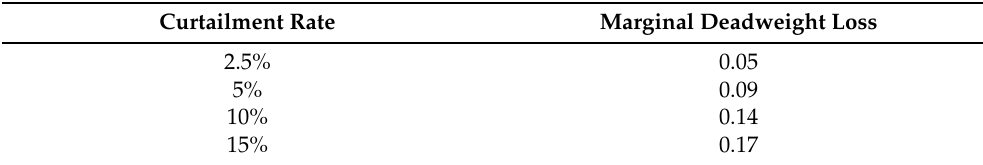
Table 5. Sensitivity of Marginal Deadweight Loss to the Curtailment